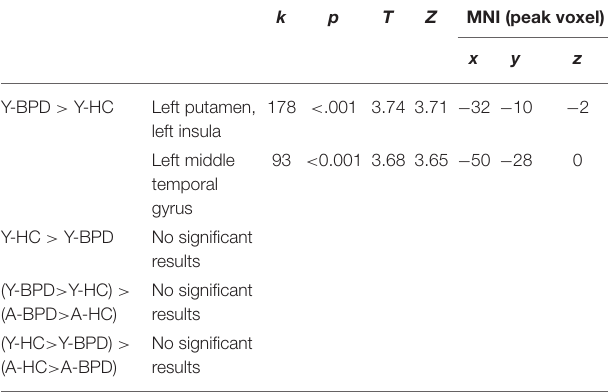
TABLE 5 | Full-factorial analysis, whole brain results during self-directed aggression phase, p < 0.001 and cluster size k ≥